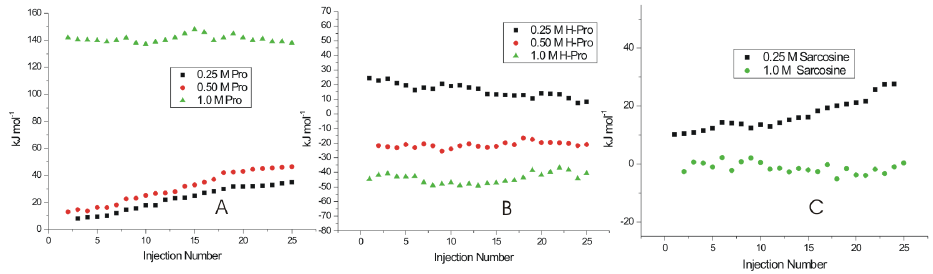
Figure 8. ITC profiles for the titrations of lysozyme solution at saturation stage (after 90 h of incubation) with (A) L-proline (B) 4- hydroxy-L-proline and (C) sarcosine at 25 6 C.